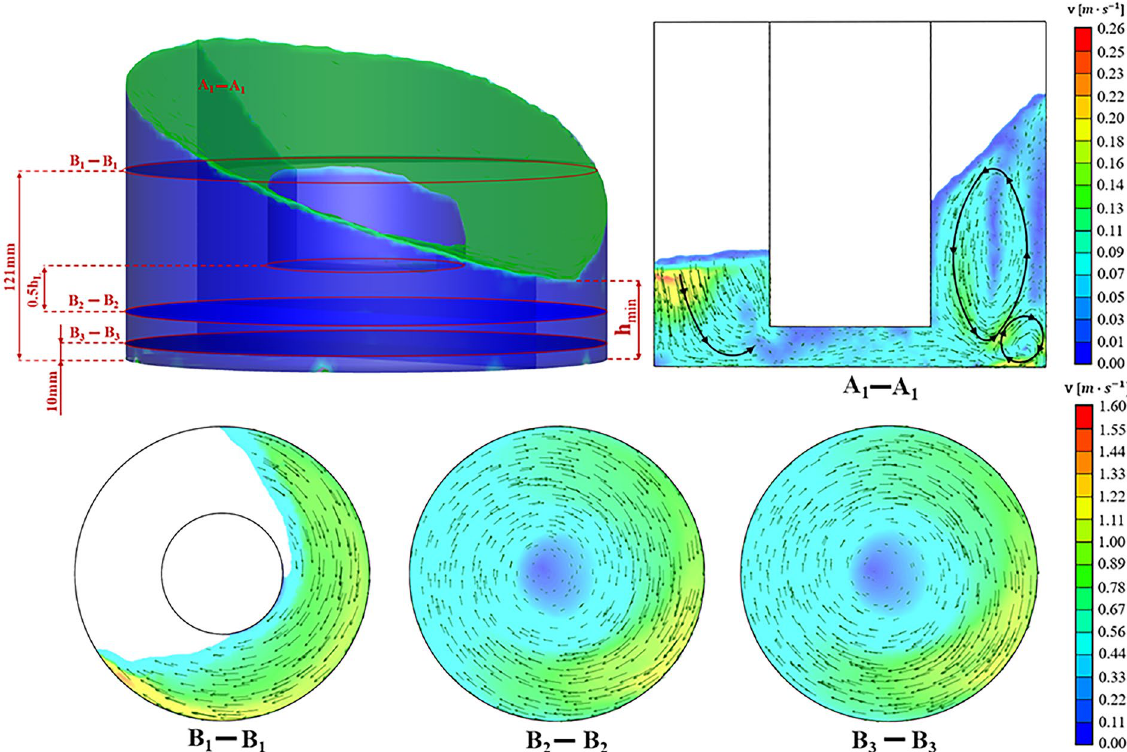
Figure 4. The velocity distribution of the flow field at different sections of the hollow cylindrical OSR with h L = 30 mm. The fluid velocity vectors was calculated in a vertical interface (A 1 -A 1 ) and three different horizontal sections (B 1 -B 1 , B 2 -B 2 and B 3 -B 3 ) respectively. The position of the vertical section was a plane of symmetry of the hollow cylinder. The heights of the three horizontal sections were 121 mm, 0.5h L (15 mm) and 10 mm respectively. The color bar on the right showed the magnitude of the fluid